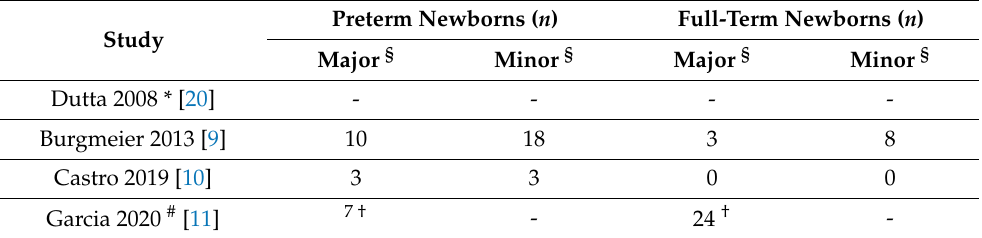
Table 3. Postoperative complications among the preterm and full-term